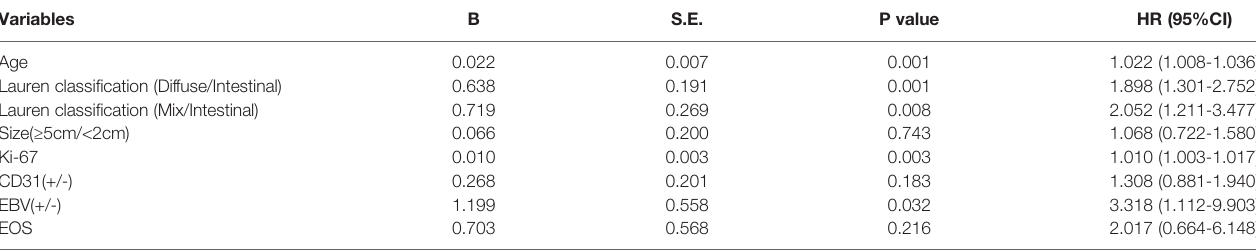
TABLE 4 | The Multivariate Logistic Regression Analyses of the PD-L1 expression of CPS ≥ 1.